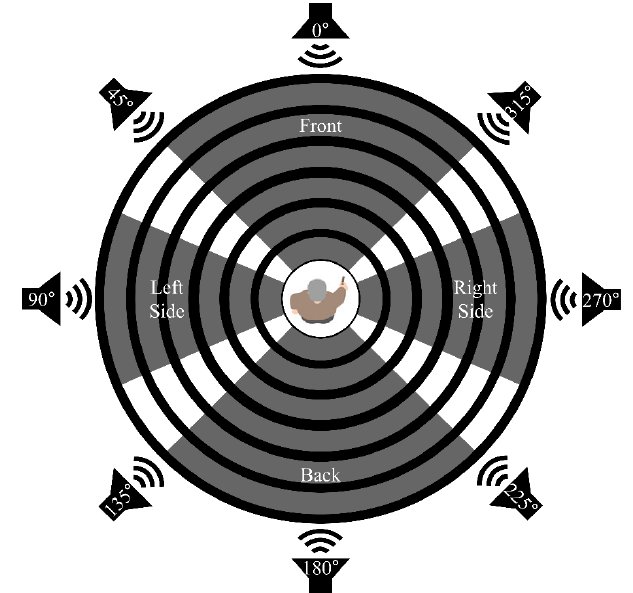
Figure 1. Diagram of the eight speakers’ measurements of the listening effort as a function of